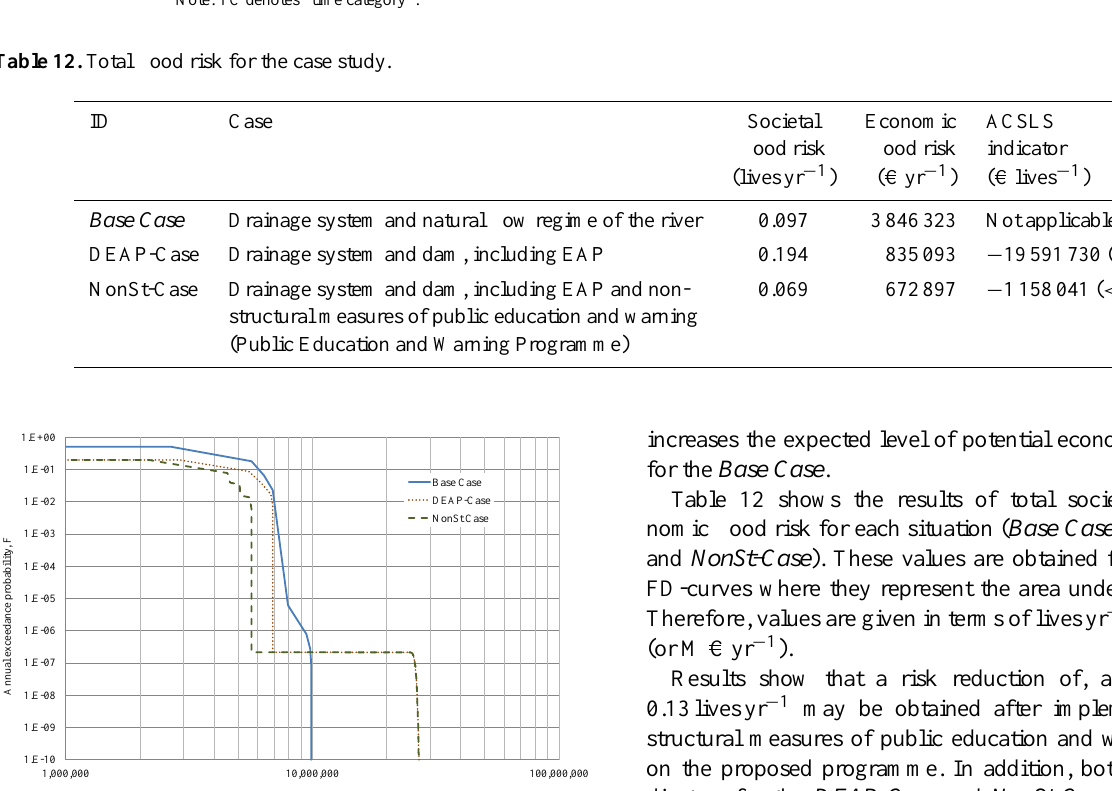
systems and higher flood severity understanding, when all sources of hazard are considered. In this case, the maximum number of potential fatalities is approximately 70